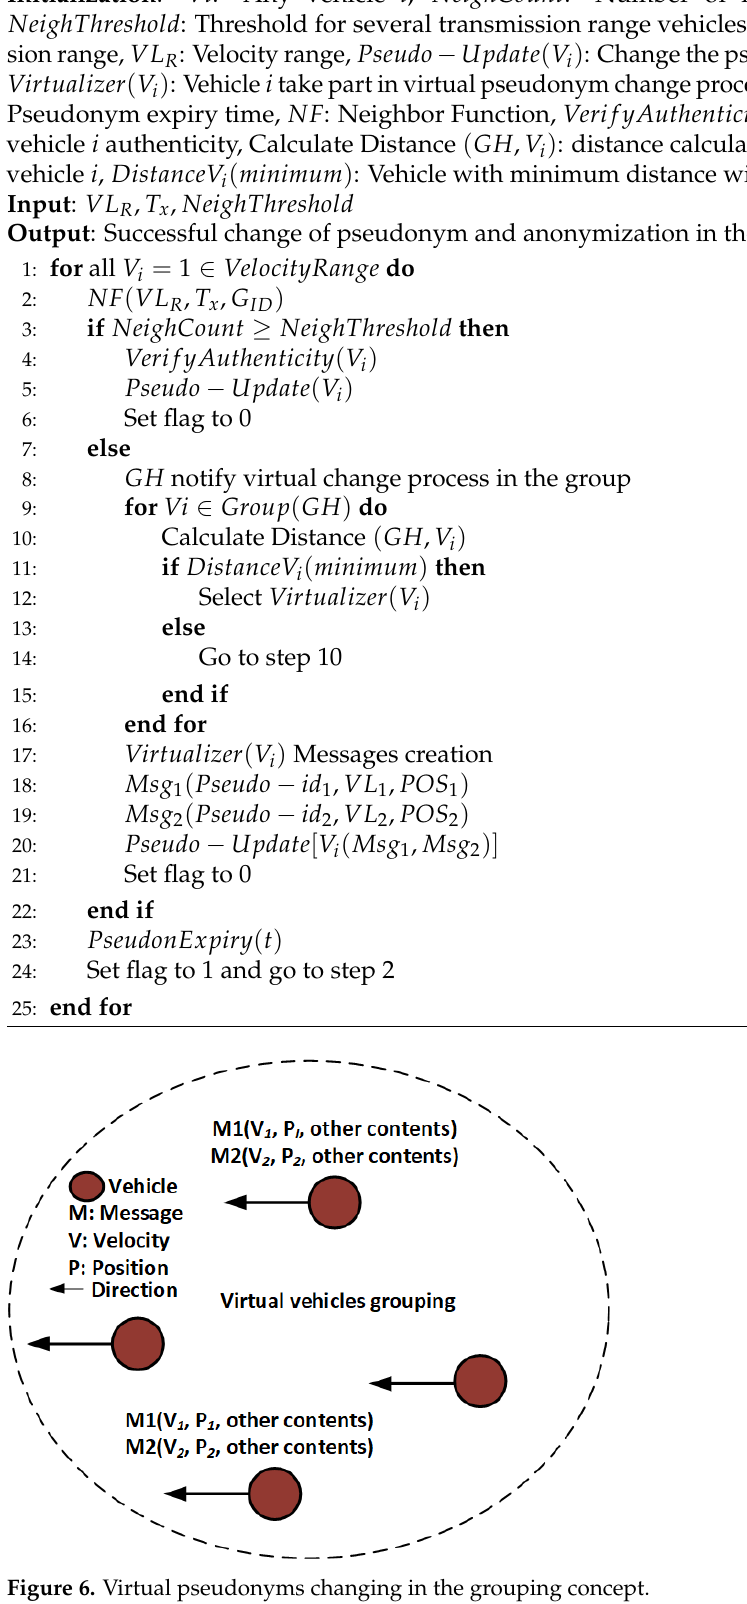
Algorithm 4 Pseudonym-Changing Protocol